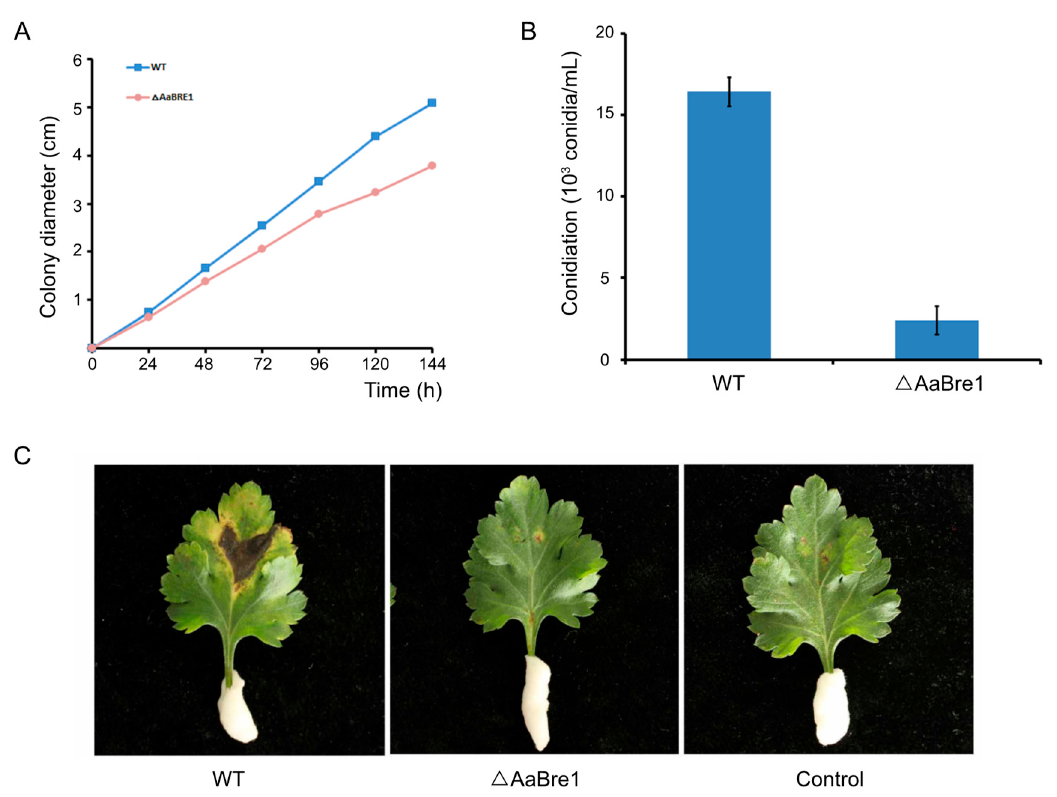
Figure 6. H2B monoubiquitination regulates mycelium growth, sporulation and pathogenesis in A. alternata . ( A ) The diameter of mycelial mats developed over time by the WT and ∆ AaBre1 strains. ( B ) Conidial numbers produced by the WT and ∆ AaBre1 strains grown on potato dextrose agar (PDA) for seven days. Whiskers indicate the SE ( n = 3). ( C ) Chrysanthemum leaves inoculated with either the WT or the ∆ AaBre1 strain. Control: mock inoculation with water.